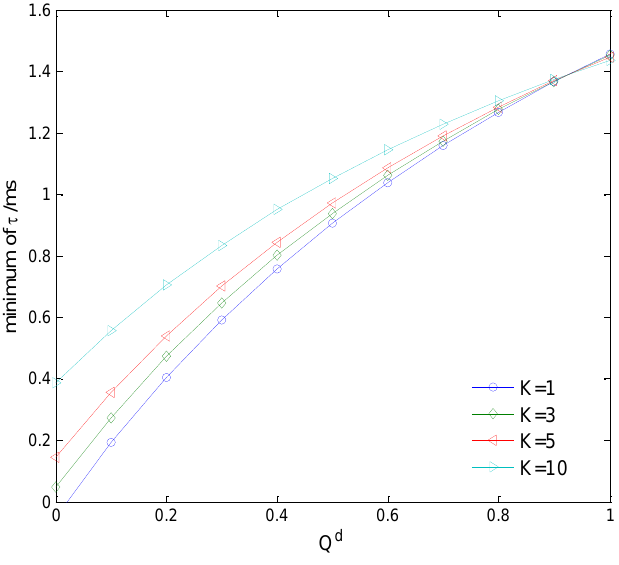
Figure 9. Minimum sensing time versus clustering number.